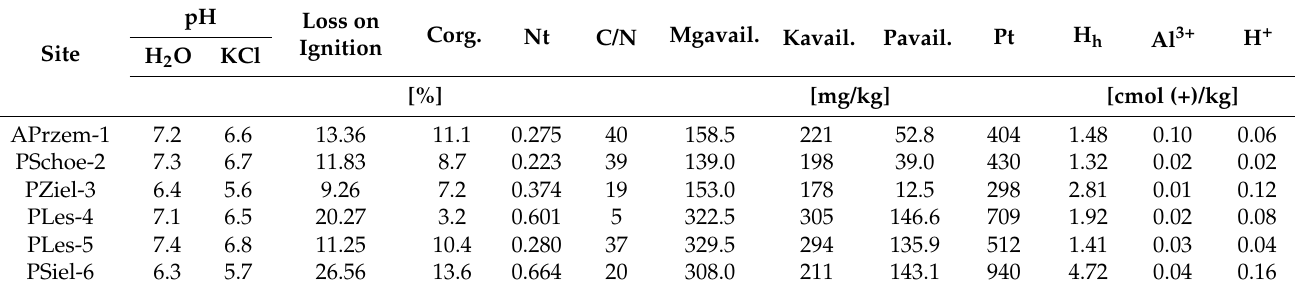
Table 3. Physico-chemical properties of soils under Ch. majus